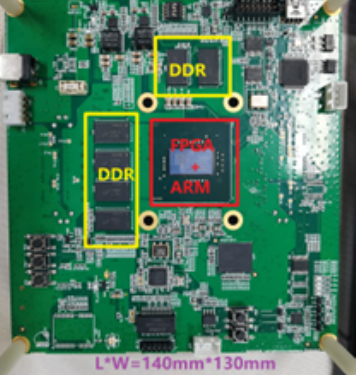
Figure A1. Radar IF signal processor